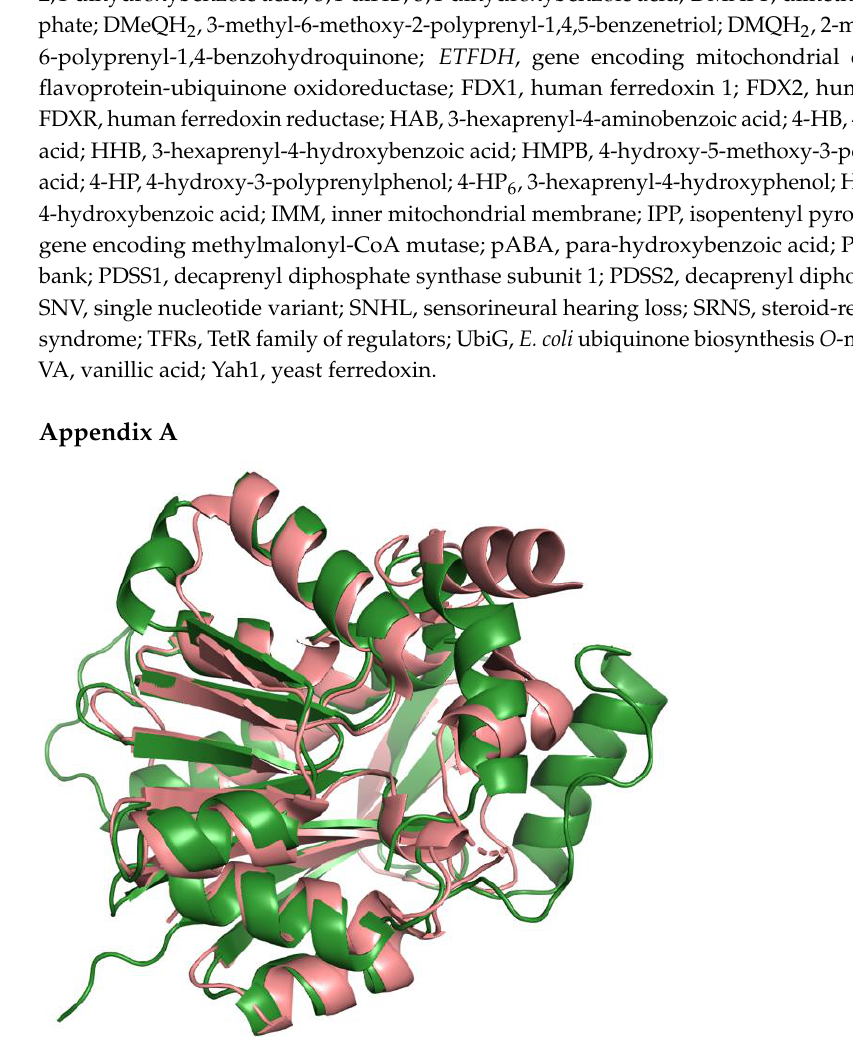
Figure A2. Multiple sequence alignment of H. sapiens COQ4, S. cerevisiae COQ4, and Nostoc sp. hom- olog Alr8543 (NCBI accession number: WP_010999537.1). Metal-liganding motif is boxed in cyan, and residues in Alr8543 (H120, D121, H124, and E136) that act to ligand the Mg 2+ ions are marked with blue dots.